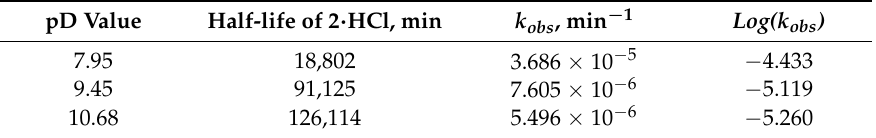
Figure 4. Representative 1 H-NMR spectral data set for hydrolysis of 2 · HCl in acetate D 2 O buffer, pD 4.85, 23 ◦ C. Table 1. Kinetic parameters for the hydrolysis of 2 . HCl in acidic D 2 O buffers at different pD values, 23 °C. Table 2. Kinetic parameters for the hydrolysis of 2 · HCl in alkaline D 2 O buffers at different pD values, 23 ◦